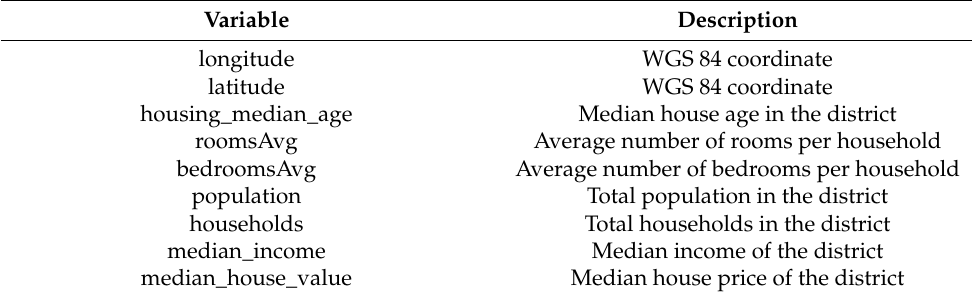
Table 2. Variable description of California housing